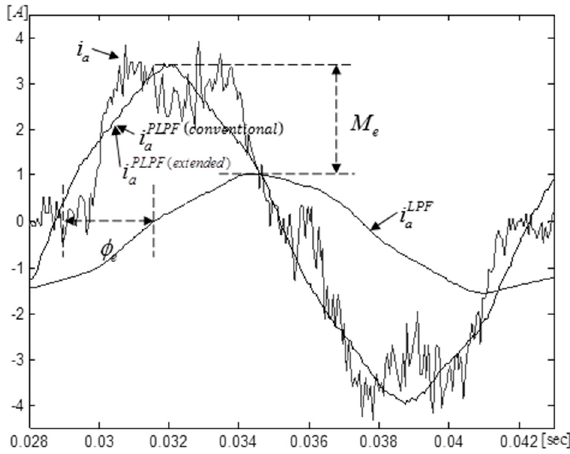
Figure 5. The filtering performance of the LPF and two PLPFs. The conventional PLPF and extended PLPF are identical from the standpoints of filter performance and compensation performance, as shown in the above results. However, from a signal flow perspective, there is a difference between the two PLPFs.